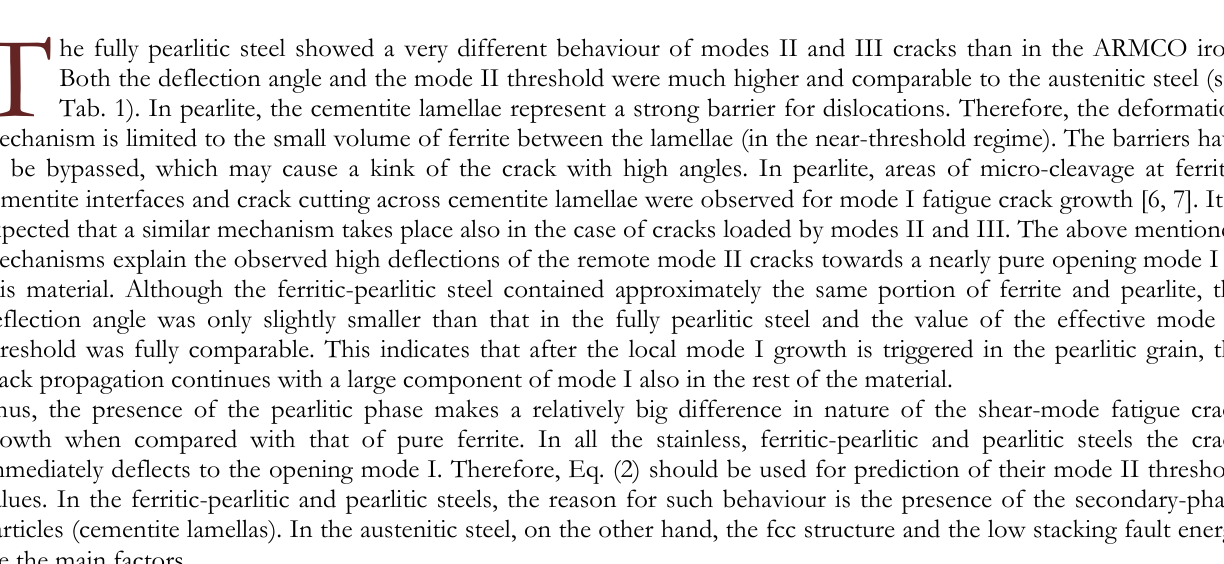
Figure 1: Microstructure of the investigated ferritic-pearlitic steel (a) and pearlitc steel (b). D